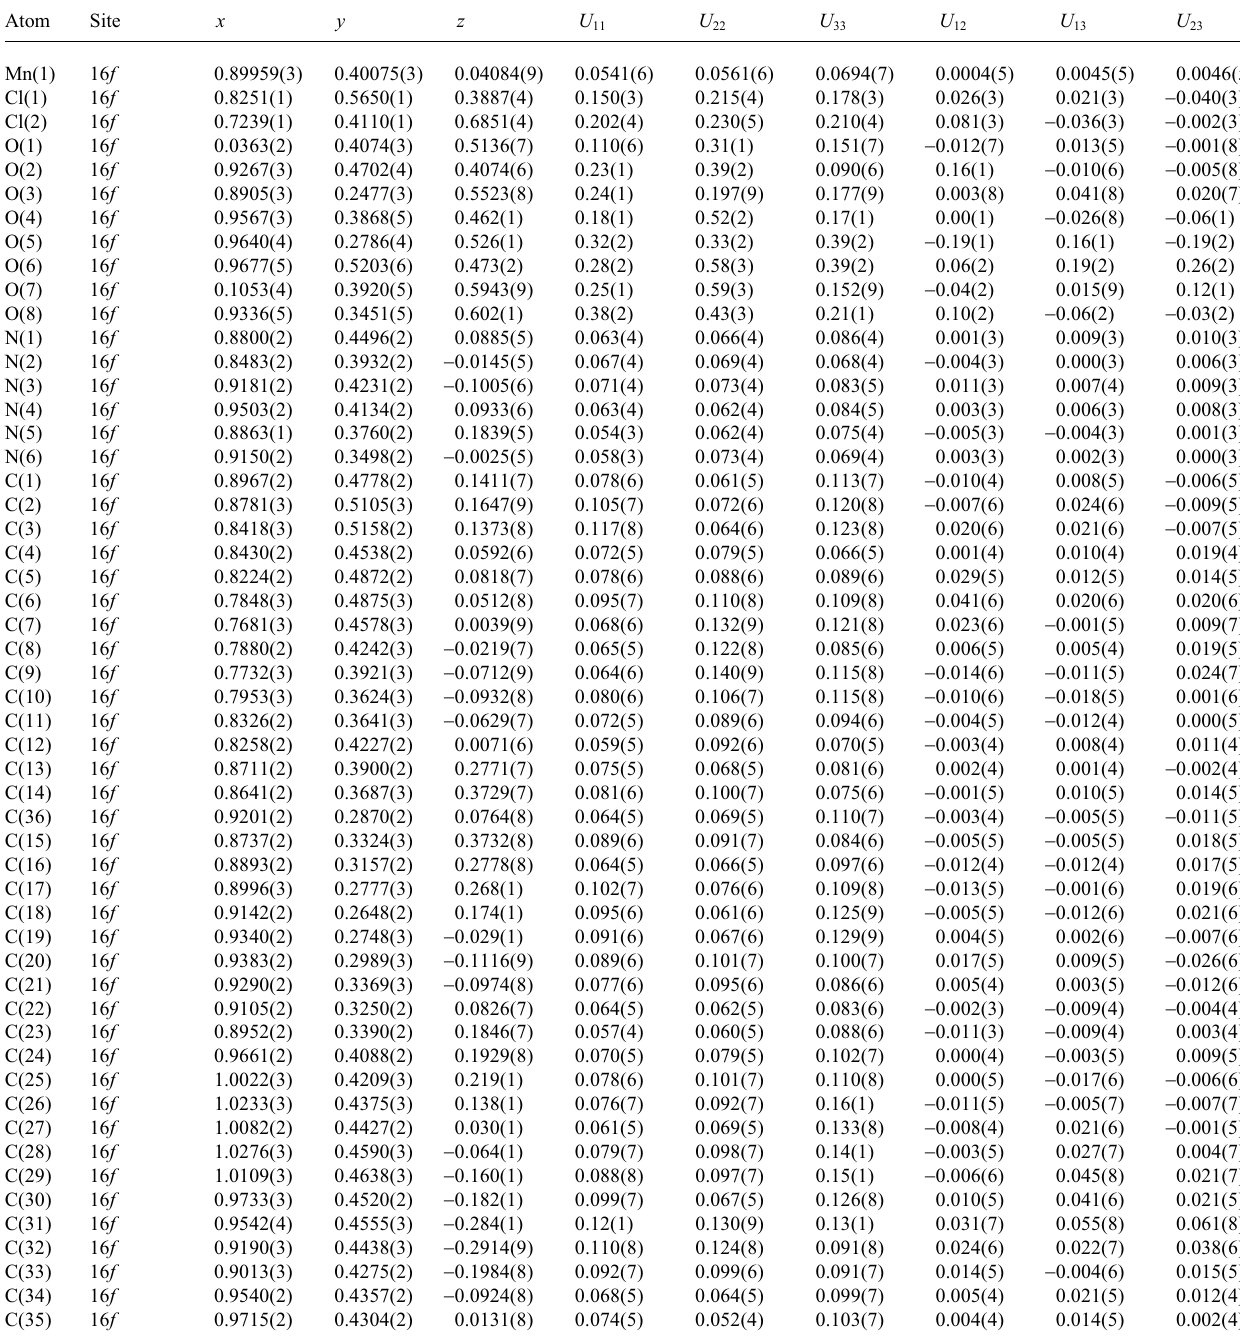
Table 3. Atomic coordinates and displacement parameters (in Å 2 )